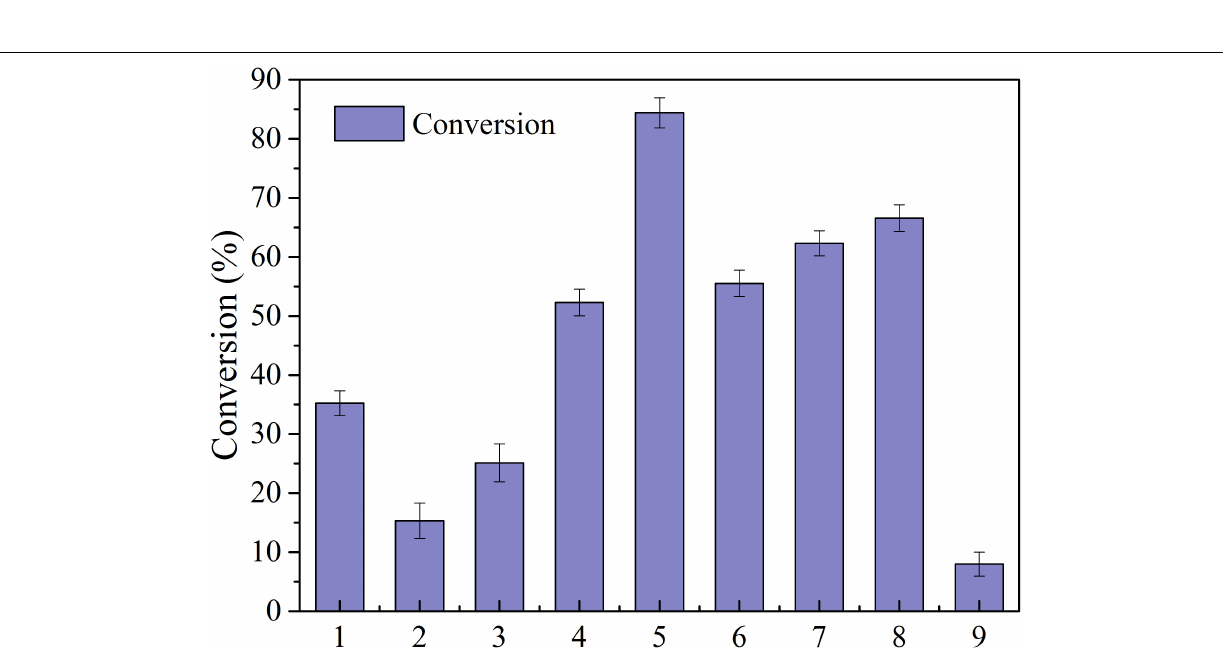
FIGURE 2 | Conversion of NH by different lipases (reaction conditions: NH 0.5mmoL/ml; Vinyl propionate 15 mmoL/mL; enzyme, 40 mg/ml; reaction temperature, 50 ◦ C; reaction time, 24 h in t-Pentanol-pyridine (1, lipase AS; 2, lipaseAK; 3, lipase AYS; 4, Lipozyme CALB; 5, Novozym435; 6, lipaseNS; 7, IM-100; 8, Lipozyme RM; 9,